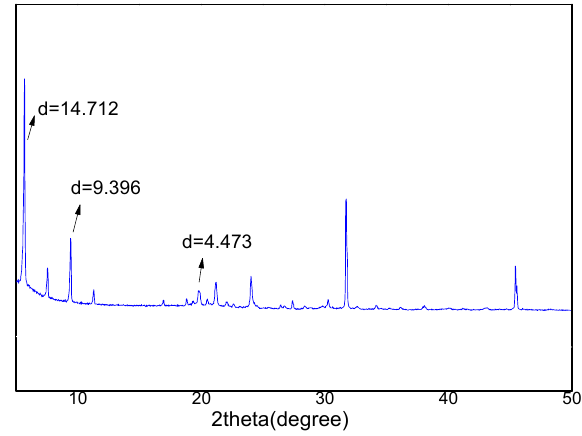
Figure 9. XRD patterns of the C4-Azo-C5-HDA gelator.